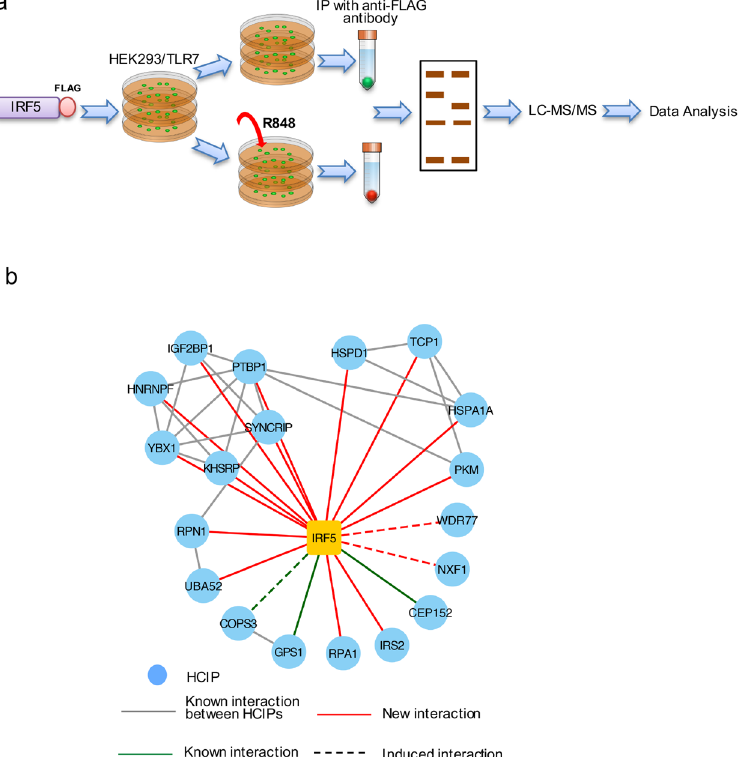
Figure 2. Affinity purification coupled with mass spectrometry (AP-MS) analysis of IRF5 protein complex. ( a ) Pipeline for AP-MS analysis of IRF5. ( b ) IRF5 protein interaction network. Legends are indicated. HCIP stands for high confidence candidate interacting